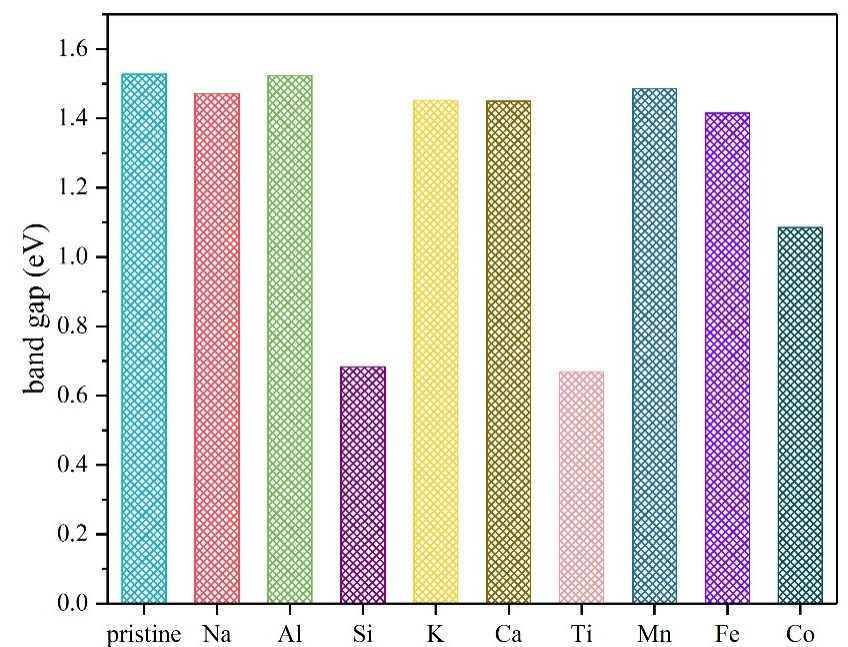
Figure 5. The electronic band gap of pristine and various doped Mg 2 NiH 4 .